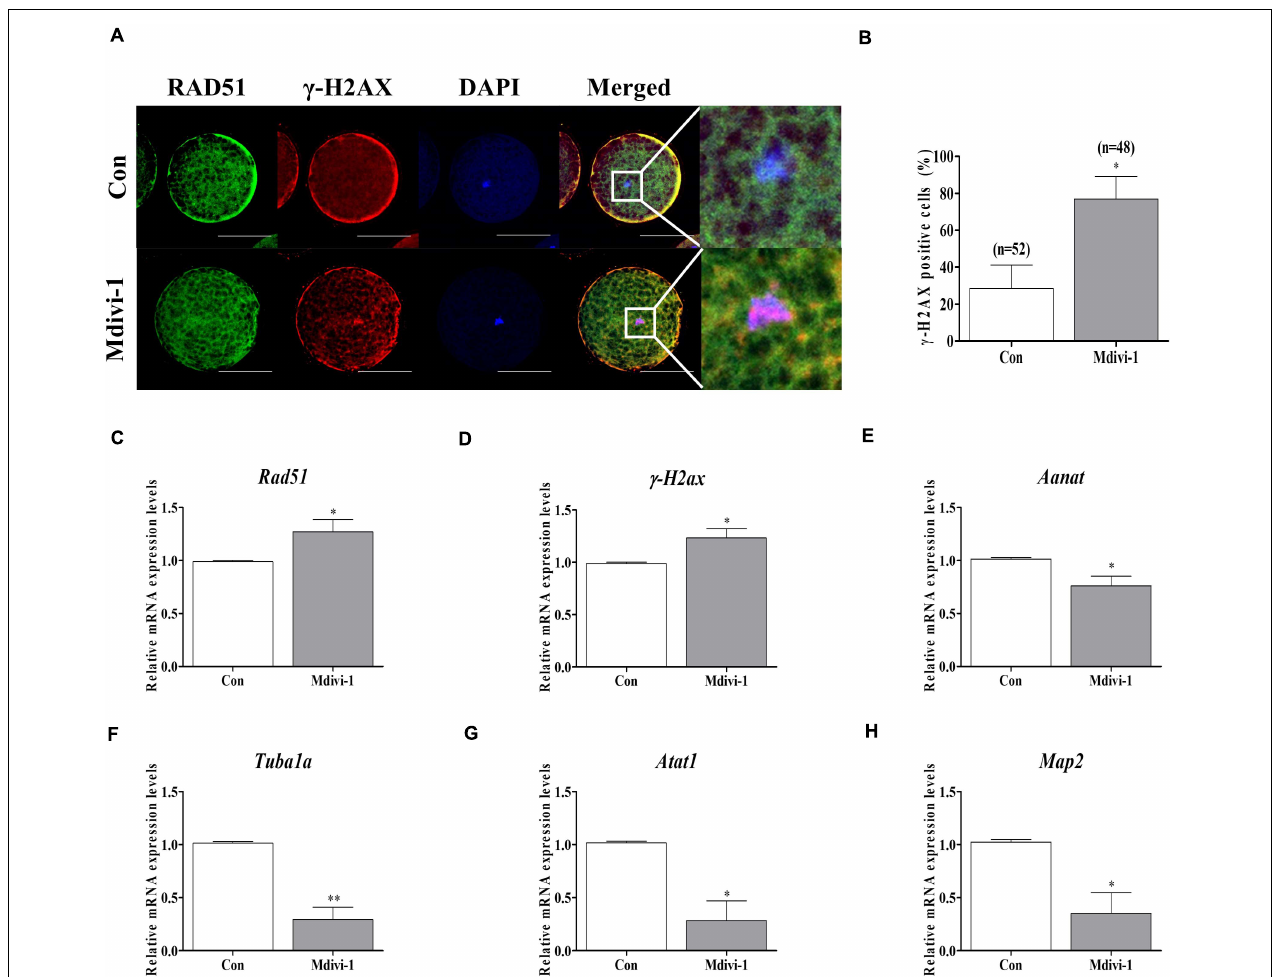
FIGURE 5 | Effects of mitochondrial division inhibitor 1 (Mdivi-1) on the DNA damage and tubulin formation-related genes in mature porcine oocytes. (A) Detection of RAD51 (green fluorescence), γ -H2AX (red fluorescence), and chromosome (blue fluorescence) expression using immunofluorescence (IF) staining in mature porcine oocytes. Scale bar: 50 µ m. (B) Percentage of γ -H2AX-positive cell ratios in mature porcine oocytes. (C,D) Expression levels of DNA damage-related genes ( Rad51 and γ -H2ax ) after Mdivi-1 treatment in mature porcine oocytes. (E) The expression level of melatonin synthesis enzyme gene ( Aanat ) after Mdivi-1 treatment in mature porcine oocytes. (F–H) Expression levels of tubulin formation-related genes ( Tuba1a , Atat1 , and Map2 ) after Mdivi-1 treatment in mature porcine oocytes. Data in the bar graph represent the mean ± SEM of three independent experiments ( ∗ p < 0.05; ∗∗ p <